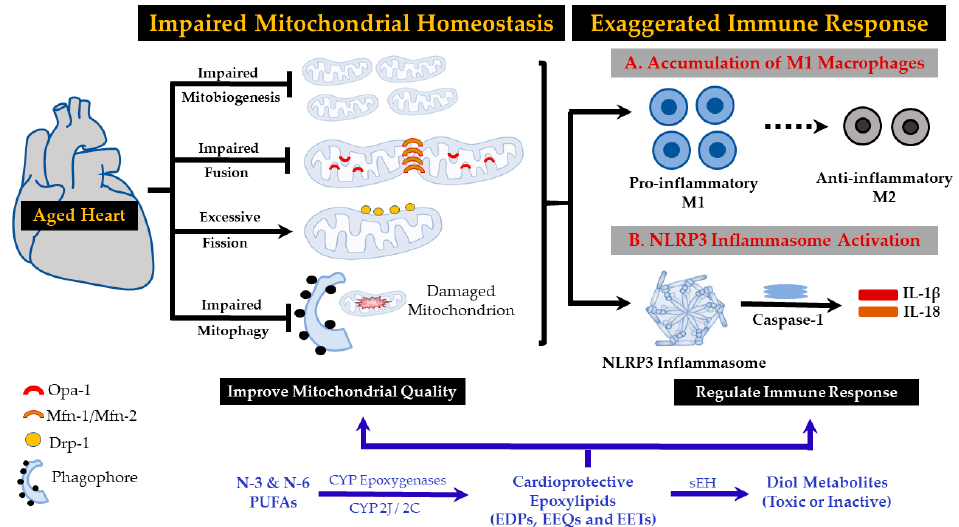
Figure 2. Schematic diagram of the potential modulatory effects of cytochrome P450 (CYP)-derived epoxylipids against cardiac inflammaging. Cardiac senescence is an intrinsic process accompanied by a general decline in mitochondrial function and impaired mitochondrial homeostasis, as evidenced by reduced mitochondrial biogenesis, dysregulated fusion, exaggerated fission and suppressed